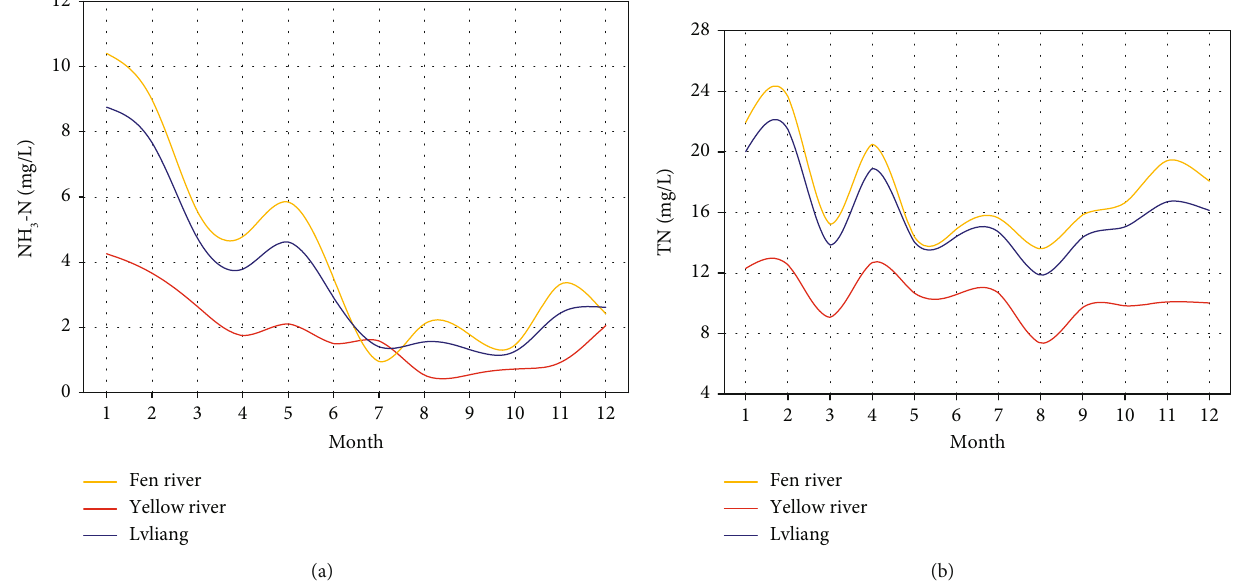
Figure 4: Comparison of NH -N and TN concentrations during January to December in 3